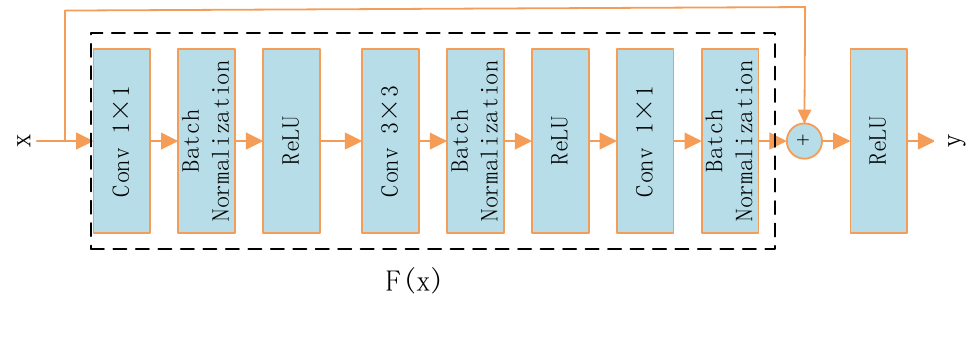
Figure 7. Residual Block